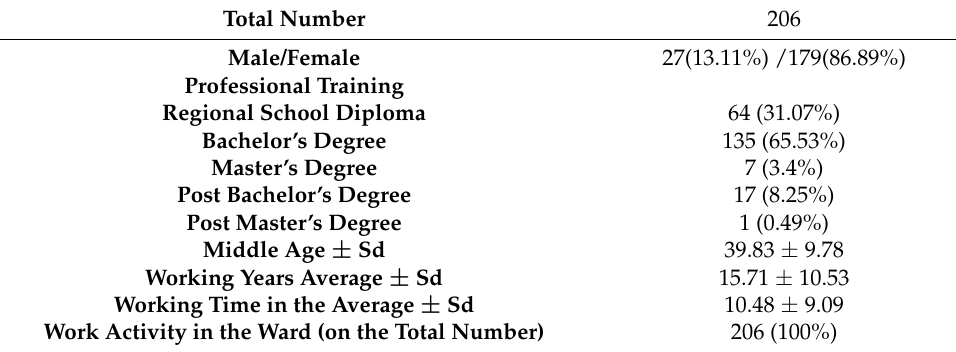
Table 2. Description of participant education.